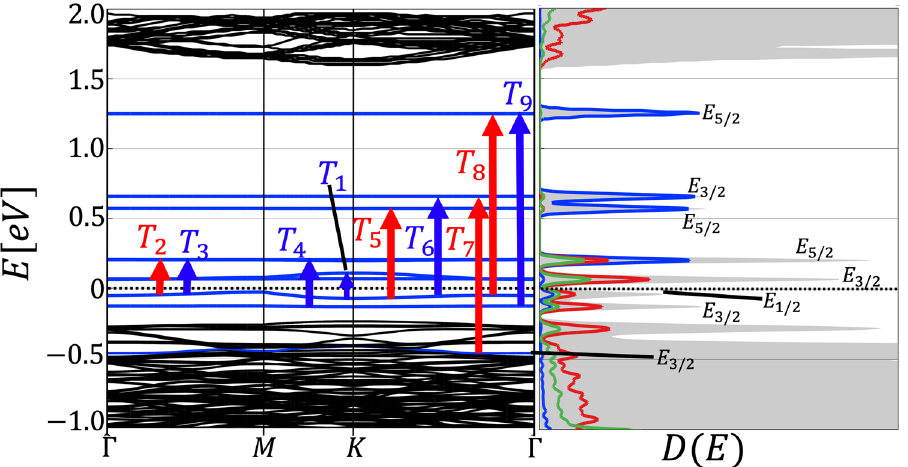
8 1 supercell of WS 2 × ×